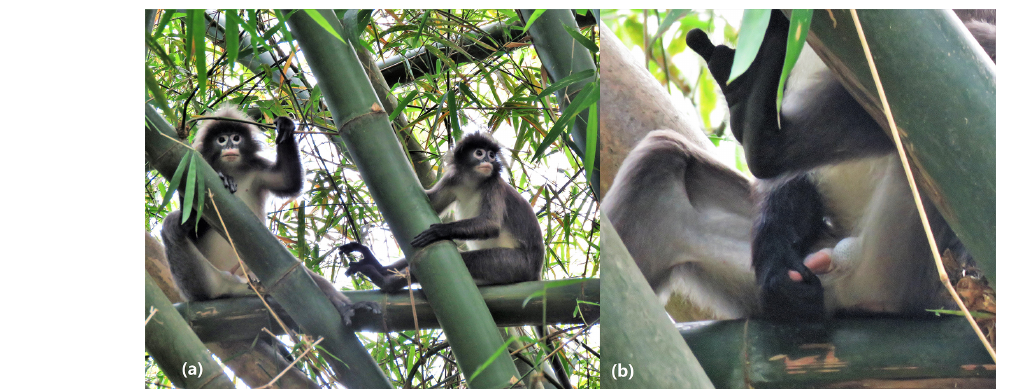
Figure 1. Two Phayre’s langur individuals (left: M2; right: M3) resting in Lawachara National Park, Bangladesh: (a) the erect penis of M2 before masturbation and (b) M2 rubbing the penis body with his right